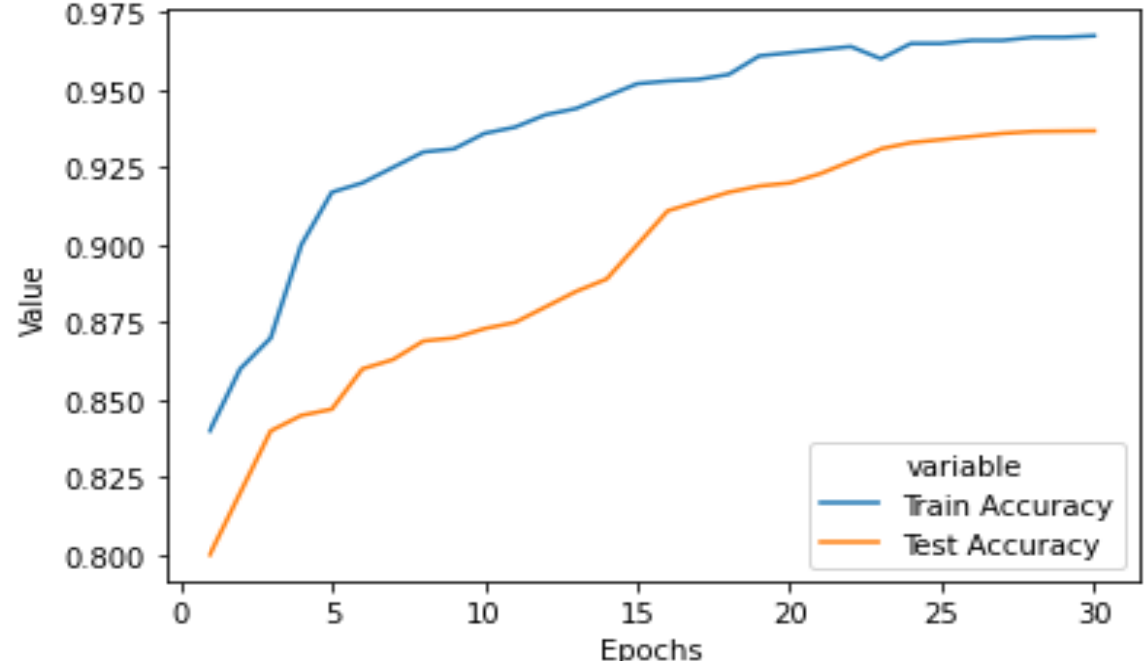
Figure 9. Testing and training accuracy of our proposed model on the augmented dataset.